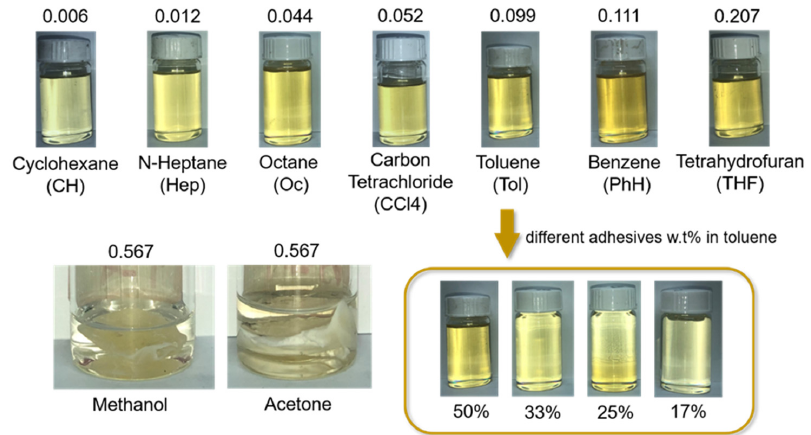
Figure 3. Adhesive solutions (adhesive wt.% = 50%) prepared with different types of solvent.